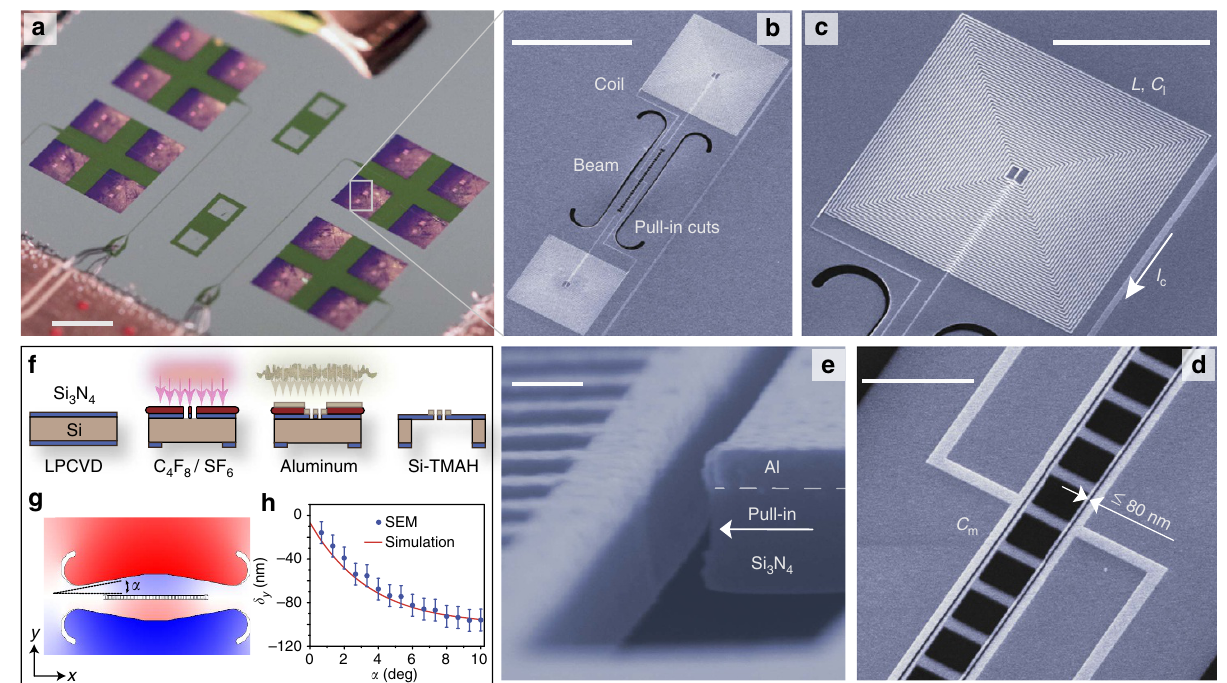
Figure 2 | Sample fabrication. ( a ) Optical image of the membrane microchip, which is mounted, bonded and clamped to a low loss printed circuit board (scale bar, 1mm). The microchip contains four sets of four membranes. In this image the Si 3 N 4 membranes of thickness 300nm are semi-transparent purple, the aluminum coated regions are grey and the uncoated silicon substrate is green. The two bright regions in the middle of each membrane correspond to the two coil resonators coupled to each nanobeam resonator. ( b ) False colour scanning electron microscope (SEM) image of the centre part of the membrane depicting two aluminum planar coils (white) coupled to two sides of a single patterned phononic crystal nanobeam with stress pull-in cuts (black). Scale bar, 100 m m. ( c ) SEM image zoom-in of the spiral inductor ( p ¼ 1 m m, n ¼ 42), showing the cross-overs needed to connect the inductor coil to the vacuum gap capacitor across the nanobeam resonator. Scale bar, 50 m m. ( d ) SEM image zoom-in of the released centre region of the nanobeam mechanical resonator and vacuum gap capacitors with gap size of s E 80nm. Scale bar, 5 m m. ( e ) Tilted SEM image of the capacitor gap showing the etch profile of the nanobeam and the aluminum electrode thickness ( E 65nm). Scale bar, 200nm. ( f ) Schematic of the main circuit fabrication steps: (i) LPCVD of stoichiometric Si 3 N 4 on both sides of a 200 m m-thick silicon substrate, (ii) C 4 F 8 :SF 6 plasma etch through the nitride membrane defining the mechanical beam resonator and pull-in cuts on the top side and membrane windows on the bottom side, (iii) electron beam lithography, aluminum deposition and lift-off steps to pattern the microwave circuit and (iv) final release of the nitride membrane using a silicon-enriched tetramethylammonium hydroxide (TMAH) solution. ( g ) Simulation of the membrane relaxation during release. The image shows the regions of positive (red) and negative (blue) displacement, d y , of the membrane. The stress release cuts (white) are shaped at an angle a to controllably narrow the capacitor gaps s during release. The rounded shape of the pull-in cut end section has been optimized to minimize the maximal stress points to avoid membrane fracturing. ( h ) Plot of the simulated (solid red curve) and SEM-measured (blue solid circles) change in the slot gap ( d y ) versus slot-cut angle a . Error bars indicate the single s.d. uncertainty in SEM measurements of the gap